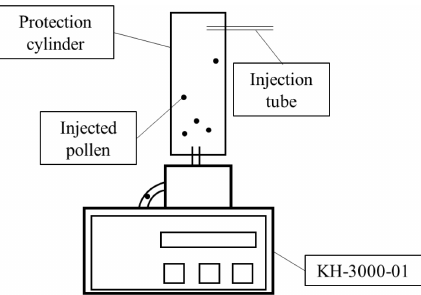
Figure 1. Schematic drawing of device set-up. Laser irradiates pollen particles inside the